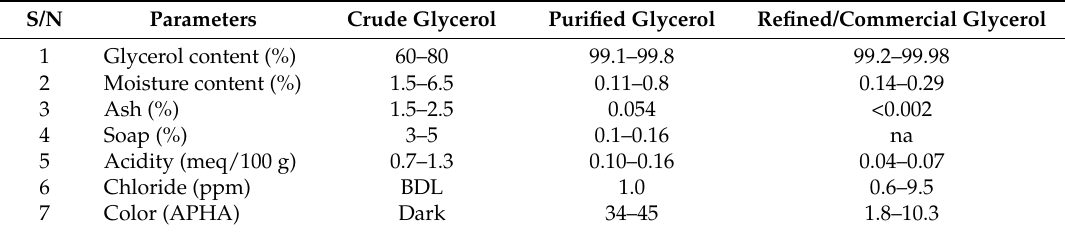
Table 3. Quality parameters of different categories of glycerol (adapted from [48]).